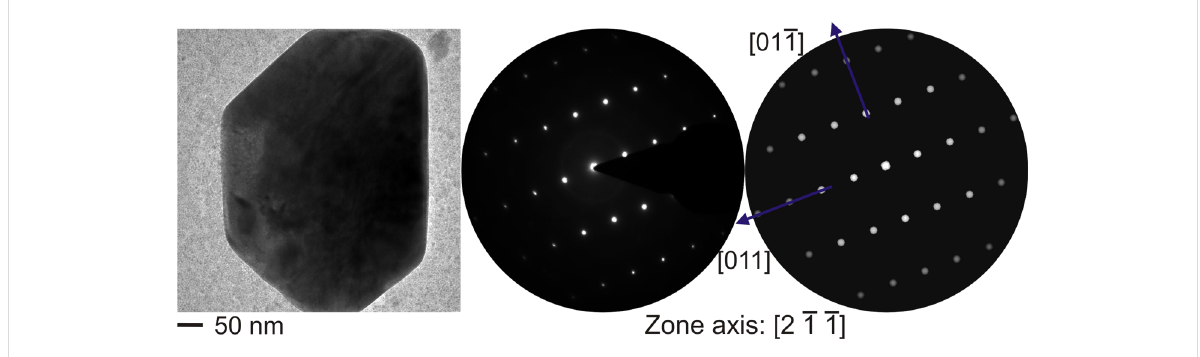
Figure 8: Micron-sized single crystalline TiO with the corresponding experimental SAED pattern and simulated SAED pattern.